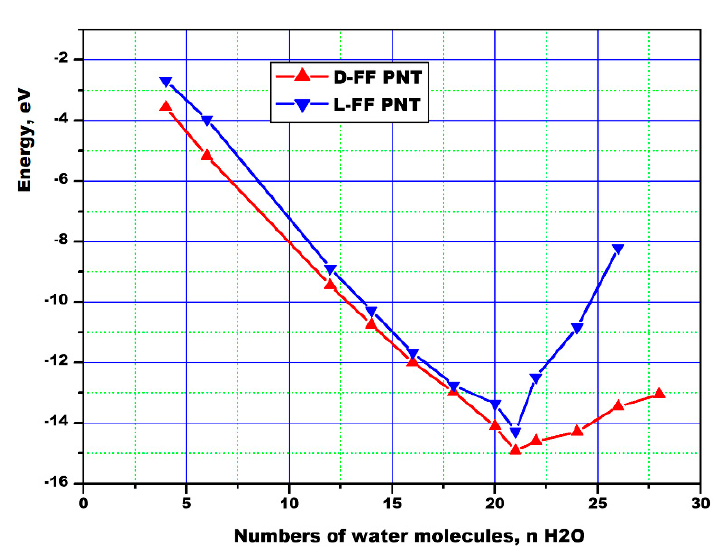
Figure 2. Average interaction energy E i between water and PNT as a function of number of water molecules confined in the hydrophilic channel of FF PNTs for each chirality types: L-FF and D-FF.